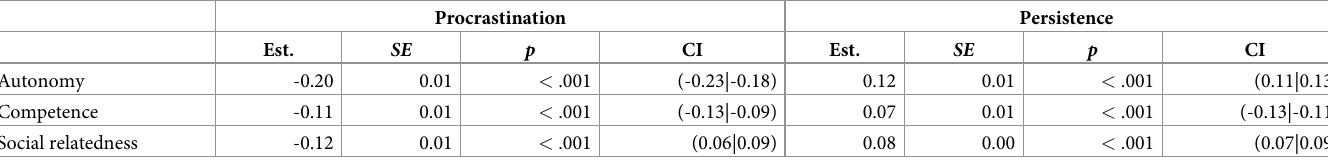
Table 3. Indirect effects of the three basic psychological needs on procrastination and persistence in the fixed path